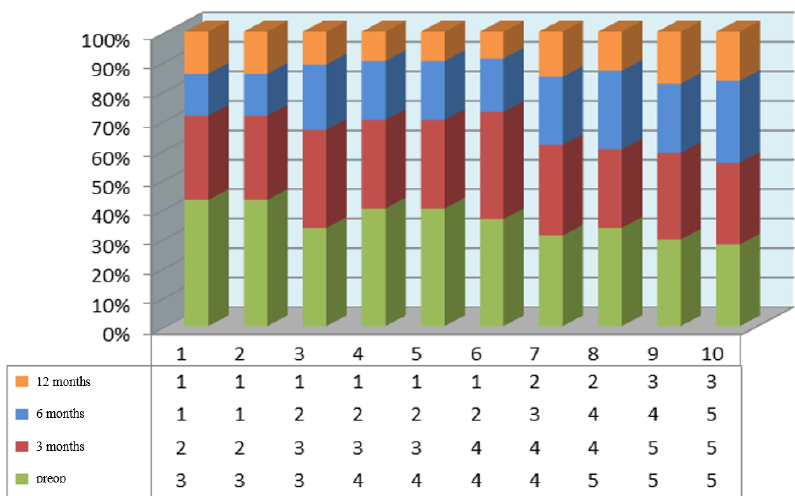
Scheme 1. Distribution of the PAI over time intervals in thegroup with dehydrated plant extract.